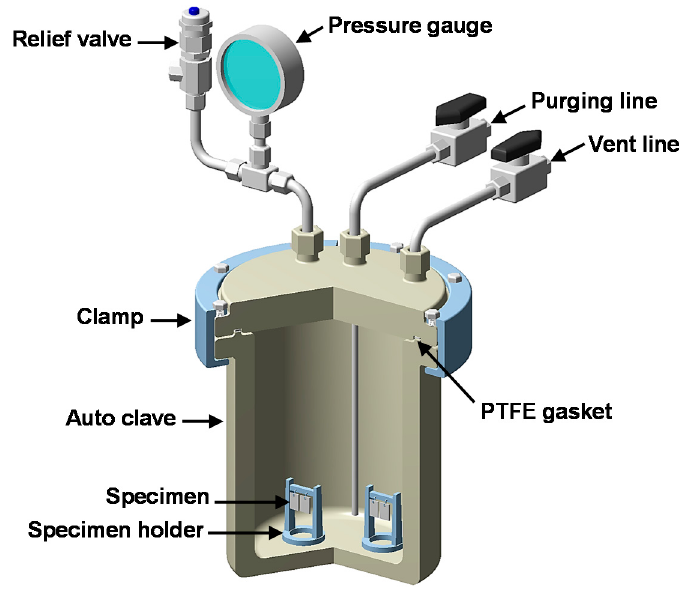
Figure 2. Test apparatus for the immersion corrosion test.